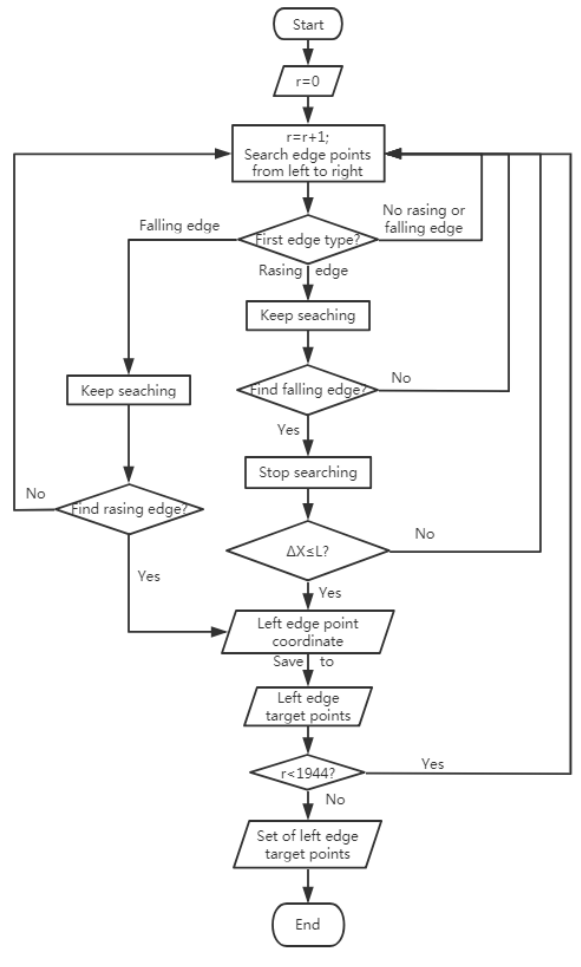
Figure 8. Flow chart of edge detection line search.